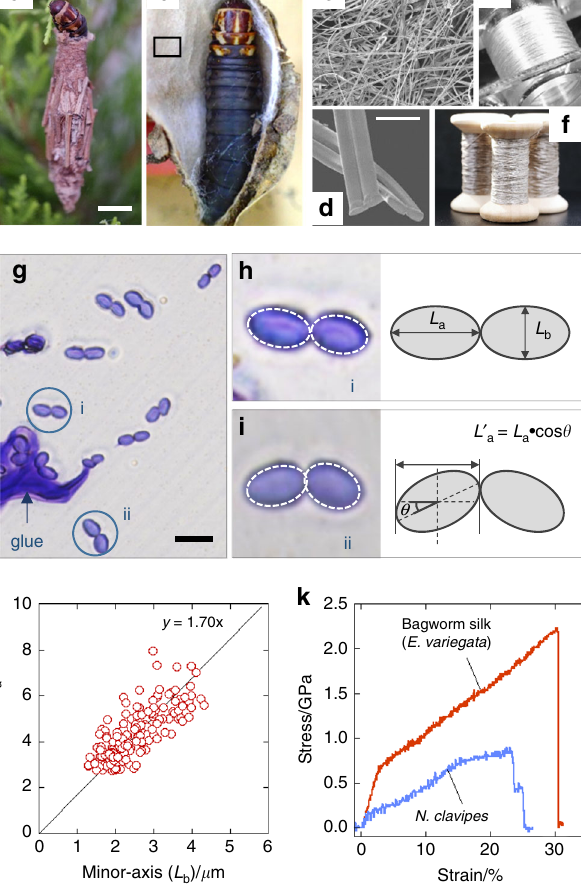
(Fig. 3d) (the original I ( q ) vs. q plot is shown in Supplementary Fig. 2) obtained from synchrotron SAXS measurement (Fig. 3c) clearly revealed at least fi ve scattering peaks, the peak positions of which approximately satisfy an integer ratio of 1:2:3:4:5. This relation revealed the existence of a well-ordered repeating structure, composed of alternating crystal and amorphous phases.